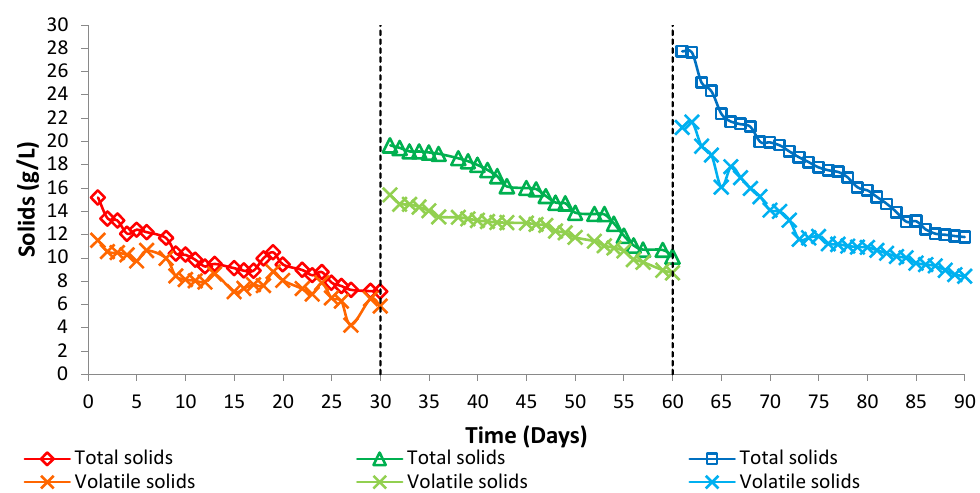
Figure 4. Degradation profiles for total solids (TS) and volatile solids (VS) during digestion in the batch mode.